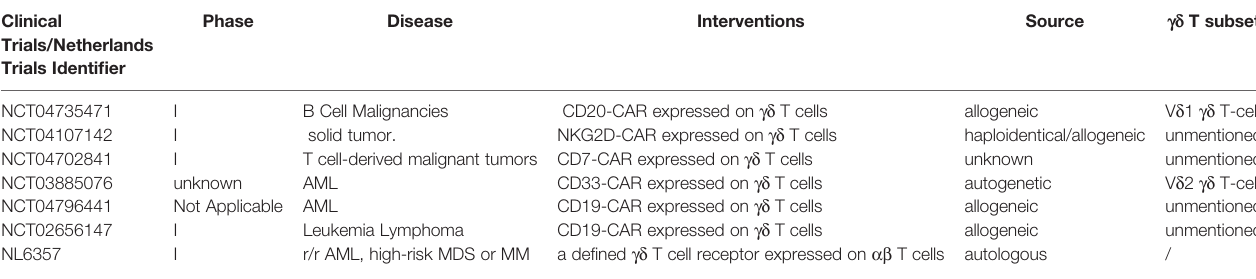
TABLE 1 | Current ongoing clinical trials of engineered gd T products. Clinical